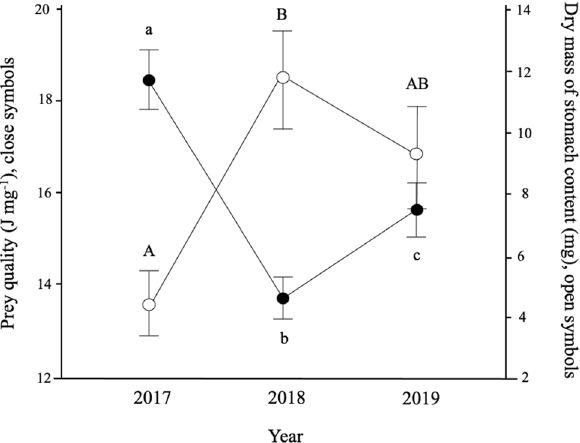
Figure 3. Variation in mean prey quality (close symbols) and dry mass of prey matter (open symbols) found in nestling’s stomachs over 3 years in black-capped chickadees and boreal chickadees sampled at the FER Macpès, Rimouski, Canada (data combined for both species, see text). We used data from 63 broods for these analyses. Of those, 39 broods were black-capped chickadees and 24 broods were boreal chickadees. Stomachs contained more dry matter in years of low food quality. Different letters (lower case for prey quality and upper case for stomach contents) indicate significant differences among years. Data are mean ± 95% confidence